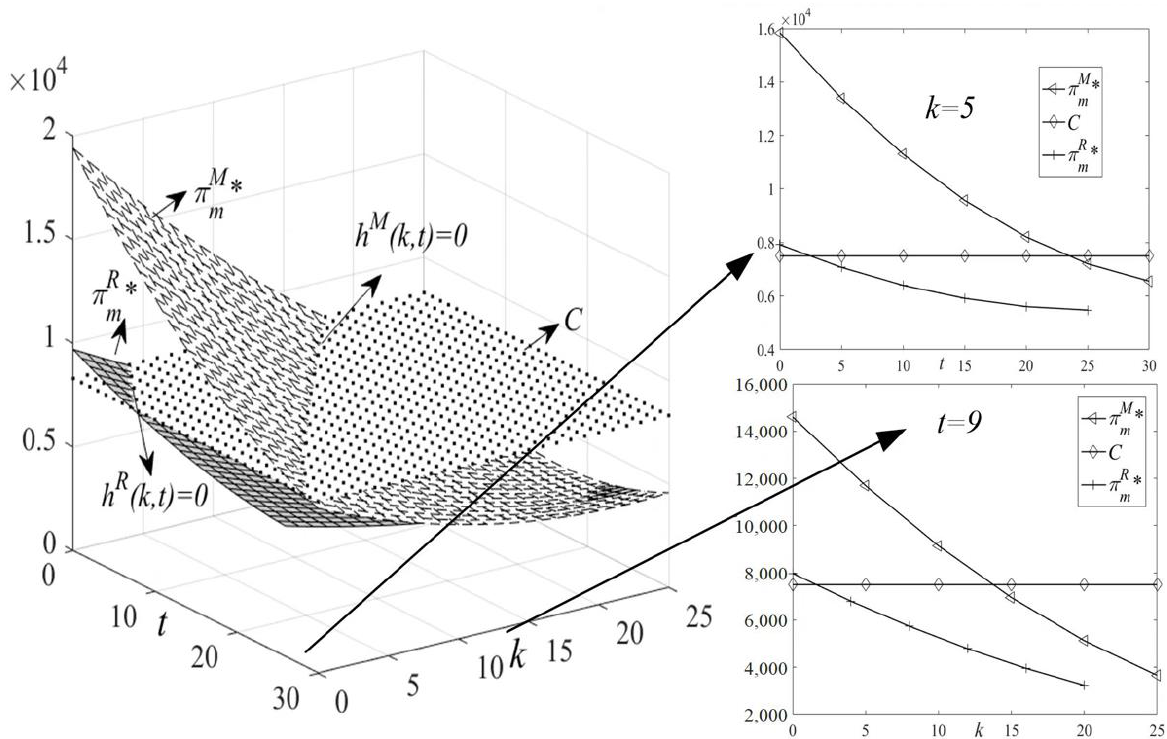
Figure 4. Changes of π m with t and k .